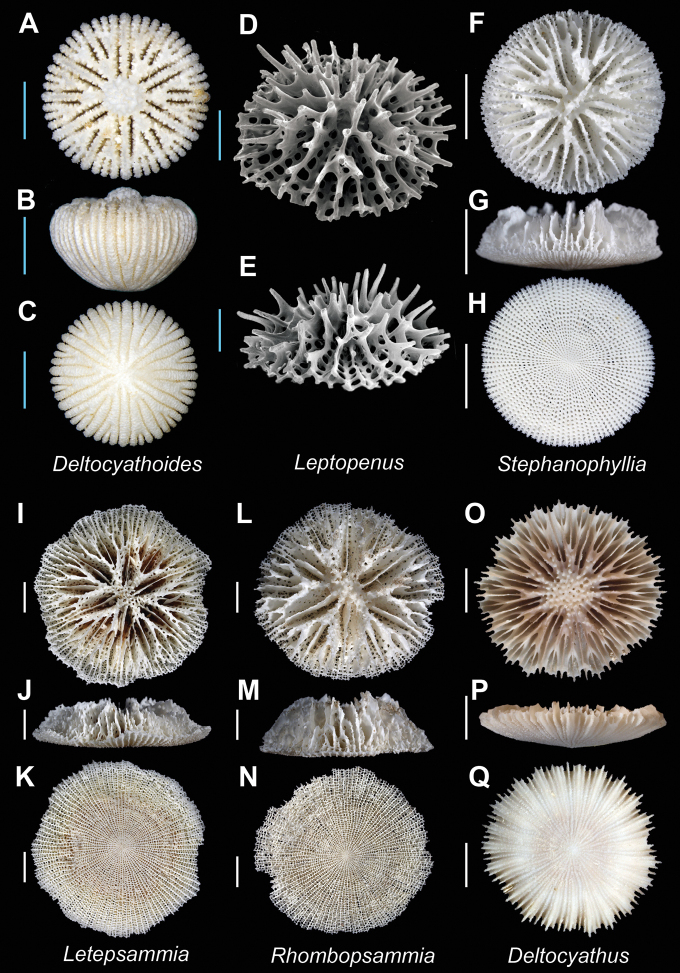
Deltocyathoides orientalis(MNHN uncatalogued, Bathus 3 stn. DW829) A, B and C  Calicular, lateral, and base view respectively; Leptopenus discus(SIO Co-1271) D (SEM) and E (SEM): Oblique views respectively; Stephanophyllia complicata (USNM uncatalogued, New Caledonia) F, G,  and H Calicular, lateral, and base view respectively; Letepsammia formosissima(USNM uncatalogued, Norfolk 2 stn. DW2032) I, J, and K Calicular, lateral, and base view respectively; Rhombopsammia niphada (USNM uncatalogued, Norfolk 2 stn. DW2069) L, M, and N Calicular, lateral, and base view respectively; Deltocyathus rotulus (MNHN-Scl.2008-0004) O, P, and Q Calicular, lateral, and base view respectively. Scale bars: blue = 1 mm; white = 5 mm. Bold face indicates type species for the genus.